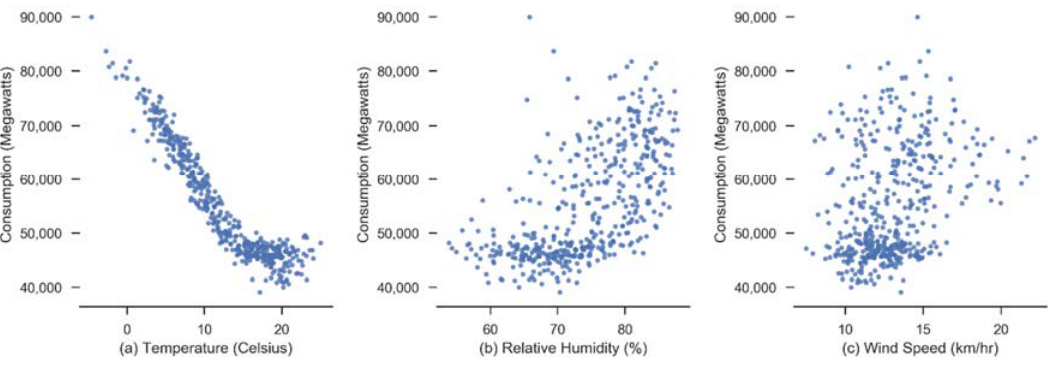
Figure 7 . Scatter Plot of Electric load vs. ( a ) Temperature ( b ) Humidity ( c ) Wind Speed.